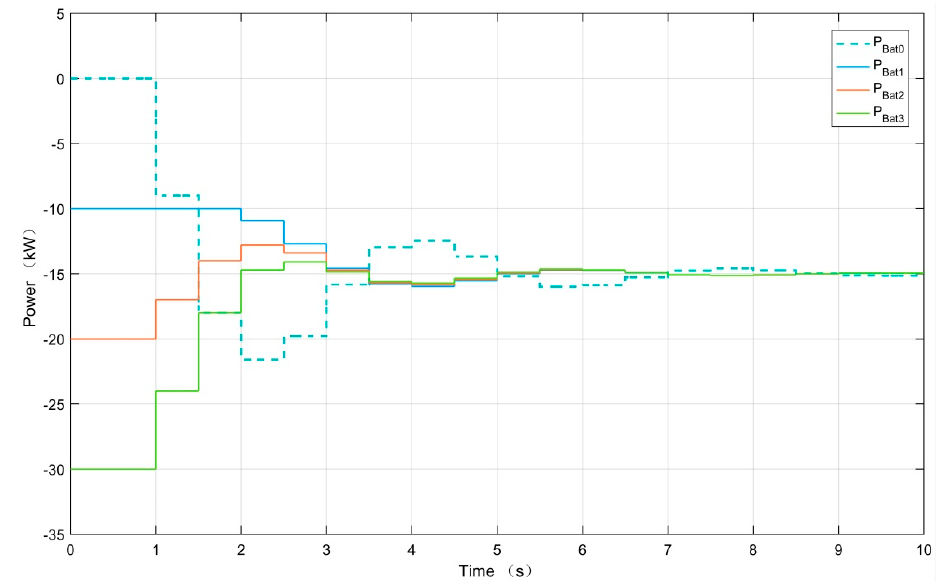
Figure 11. Exchange power of modules ( τ = 0.2 s, T = 0.5 s).